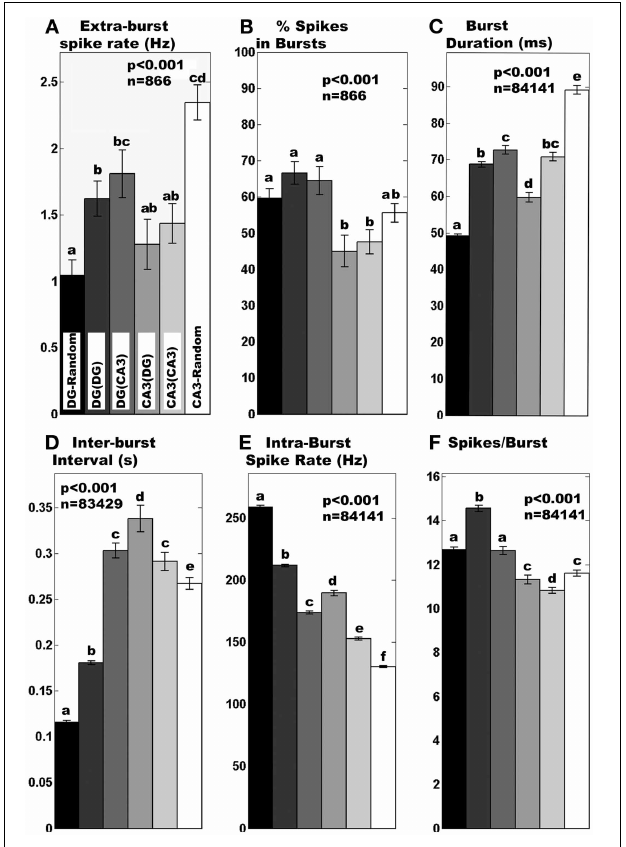
FIGURE 3 | Region-specific burst dynamics. Normal distribution statistics indicate (A) mean extra-burst spike rate differs (i) in tunnels compared to corresponding random cultures and (ii) is higher for DG than CA3 apposed across tunnels. (B) Percent spikes in bursts are generally higher for any DG culture than any CA3 culture. Log normal distribution statistics apply to (C–F) . (C) Burst duration was longer for DG than CA3 when they were apposed. For random cultures without tunnel devices, DG burst durations are much lower than CA3 random cultures. (D) Inter-burst intervals are lengthened by 50% in DG apposed to CA3 compared to DG self-apposed across tunnels and 300% compared to DG in random networks. Similarly, inter-burst times are longer for CA3 apposed to DG than CA3 apposed to itself or random CA3 cultures. (E) Intra-burst spike rates are shortened by 20% in DG apposed to CA3 compared to DG self-apposed across tunnels but longer in the reverse direction. (F) Spikes per burst decreased by 14% in DG apposed to CA3 compared to DG self-apposed across tunnels and even less in the reverse direction. In all cases n displayed is total degrees of freedom from burst or non-burst segments from 3min recordings of networks of 4 random DG, 4 random CA3, 8 DG(DG), 8 CA3(CA3), 5 DG(CA3), and 5 CA3(DG). Different letters above bars indicate significant differences (a shared letter indicates a non-significant comparison)